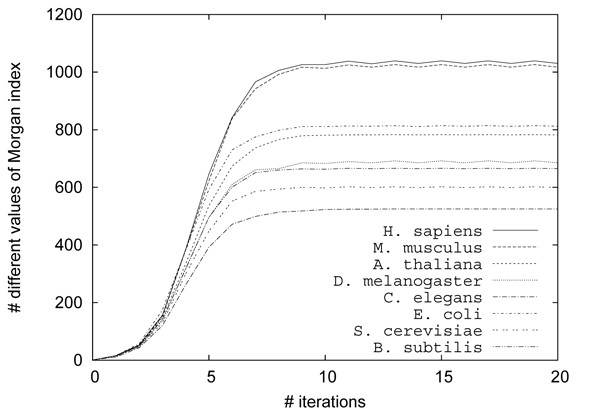
Results on the number of different values of Morgan indices for metabolic networks of several organisms, H. sapiens, M. musculus, A. thaliana, D. melanogaster, C. elegans, E. coli, S. cerevisiae, and B. subtilis for 1-20 iterations of the Morgan index procedure.